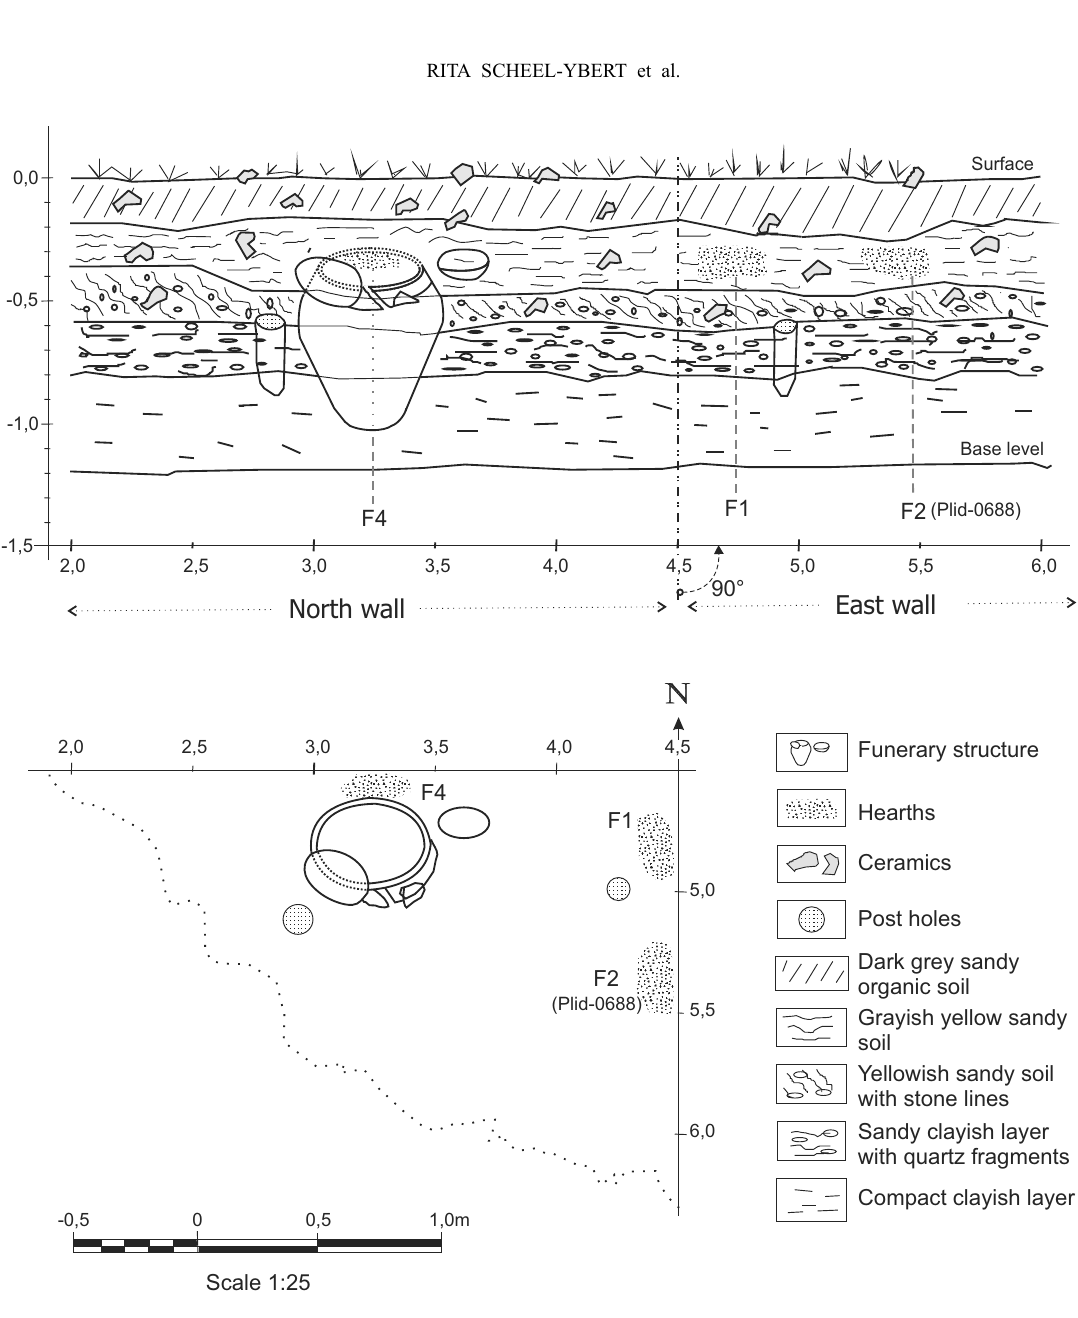
Fig. 2 – Schematic stratigraphic profile of north and east walls from Sector 2, Morro Grande archaeological site, and partial surface plan of the same